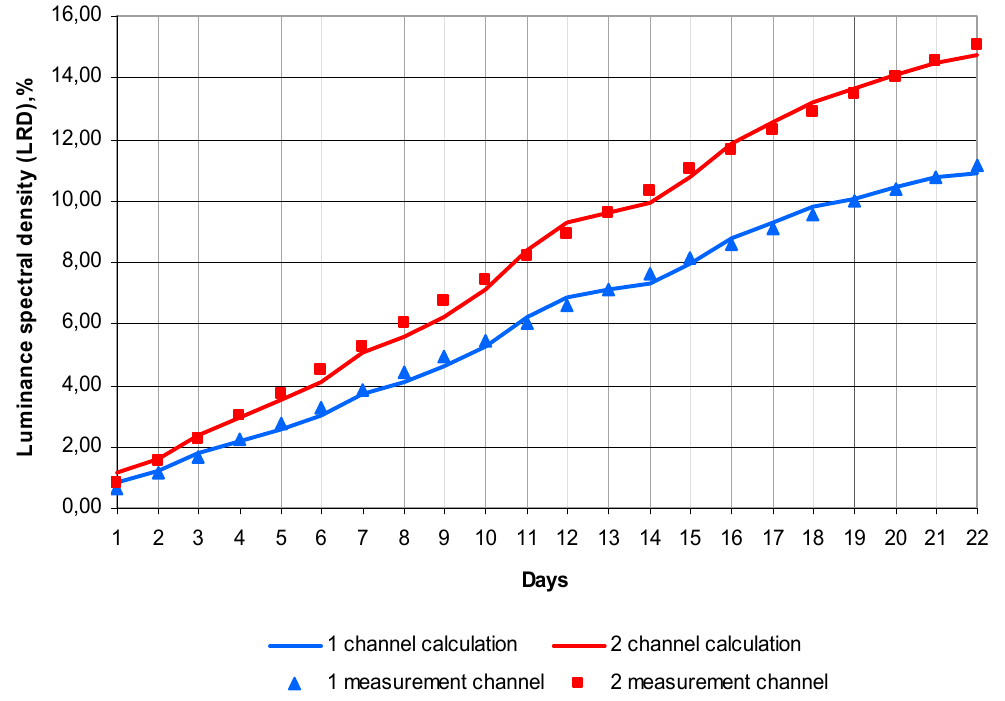
Figure 2. Dynamics of the field-averaged parameters of reflection of spring wheat sowing in the time interval preceding heading. 1 channel—red, 2 channel—near IR.